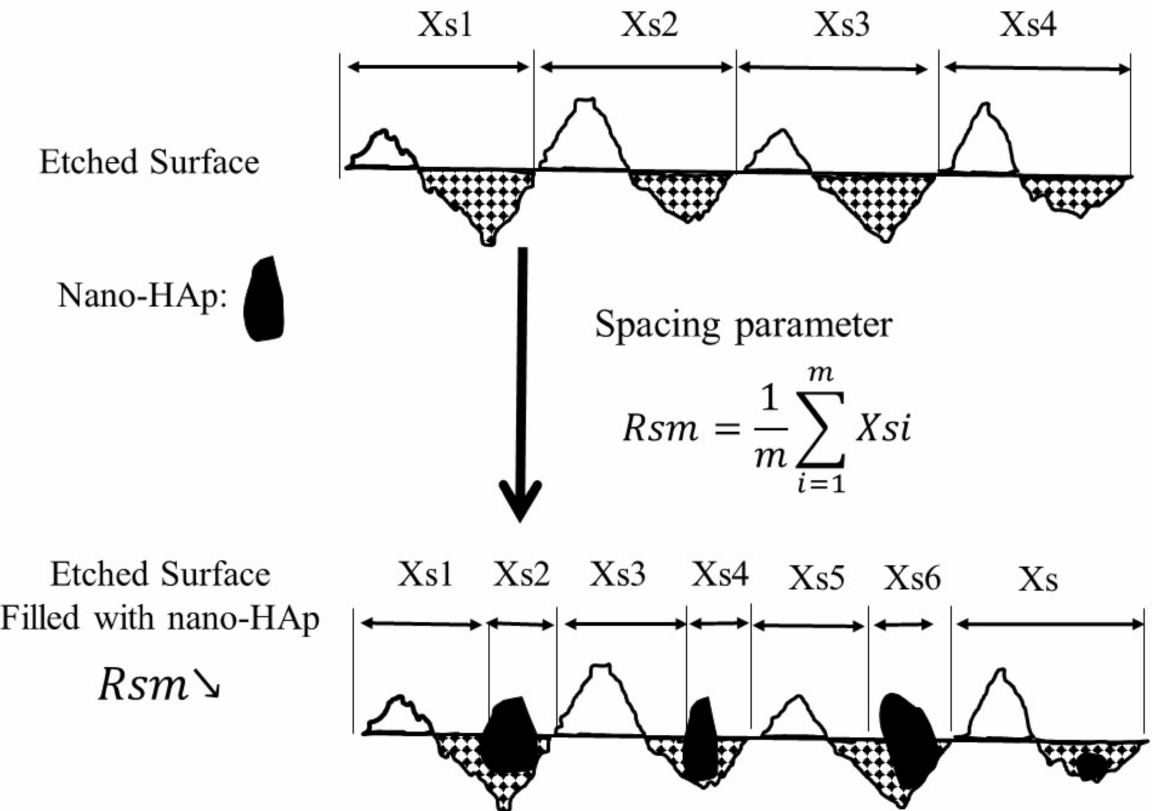
Figure 4. Proposed fast-repairing model for the AFM spacing